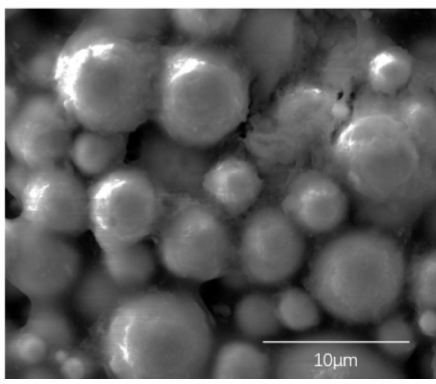
Figure 5. SEM image of WB zinc-based coating after 36 h storage.